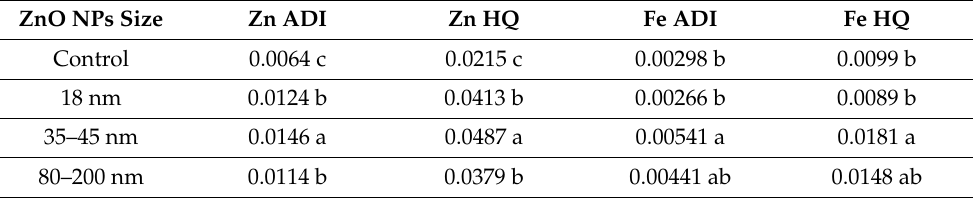
Table 4. The values of average daily intake (ADI, mg kg − 1 day − 1 ) and hazard quotient (HQ) after foliar application of ZnO nanoparticles (ZnO NPs). Threshold limits: HQ = 1. Different letters represent significant differences. The data were processed using analysis of variance (ANOVA) according to the Tukey (HSD) multiple range test at the confidence level of p =